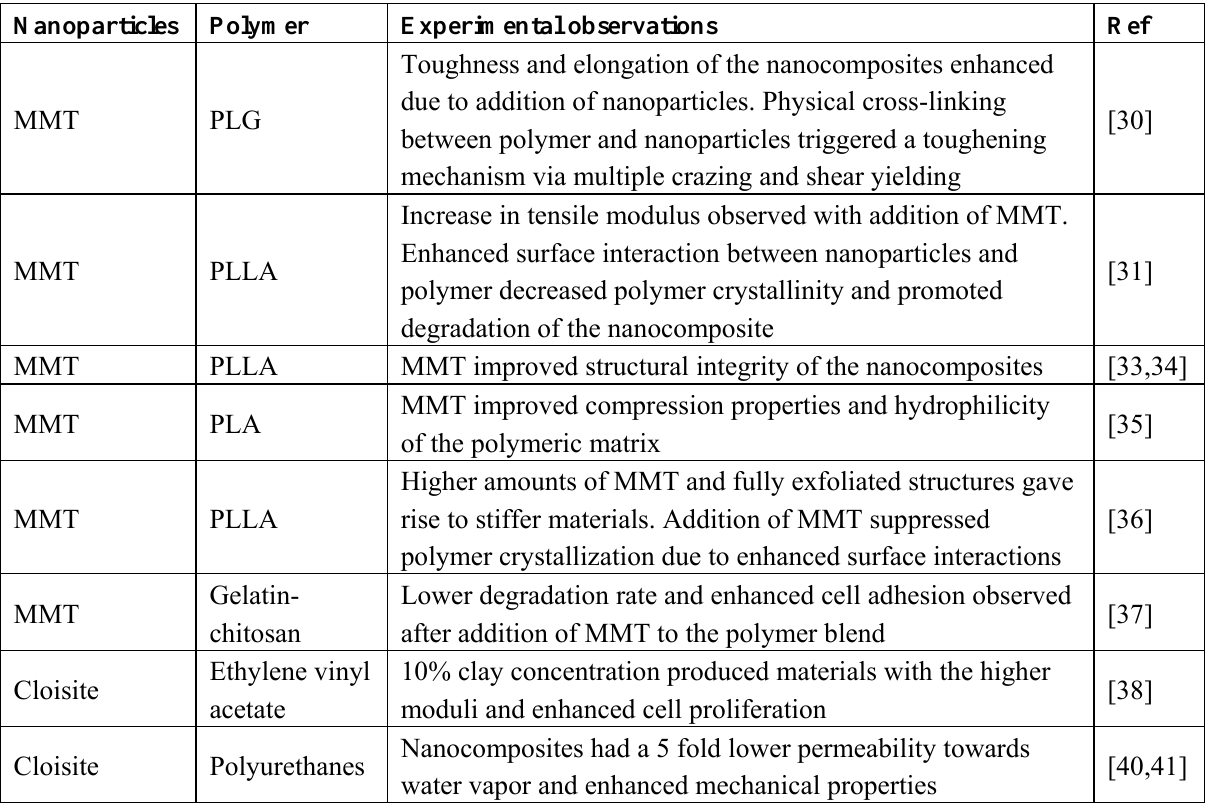
Table 1. Some biomedical polymers reinforced with Montmorillonite (MMT clay) and Cloisite (modified MMT clay)